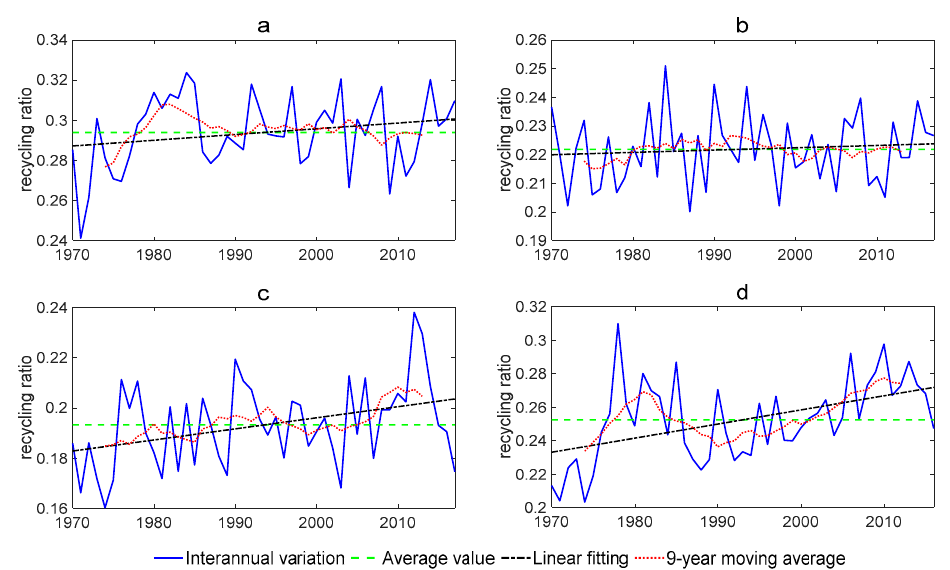
Figure 5. Interannual variation of PRR in SAIE from 1970 to 2017 in spring ( a ), summer ( b ), autumn ( c ), and winter ( d ).